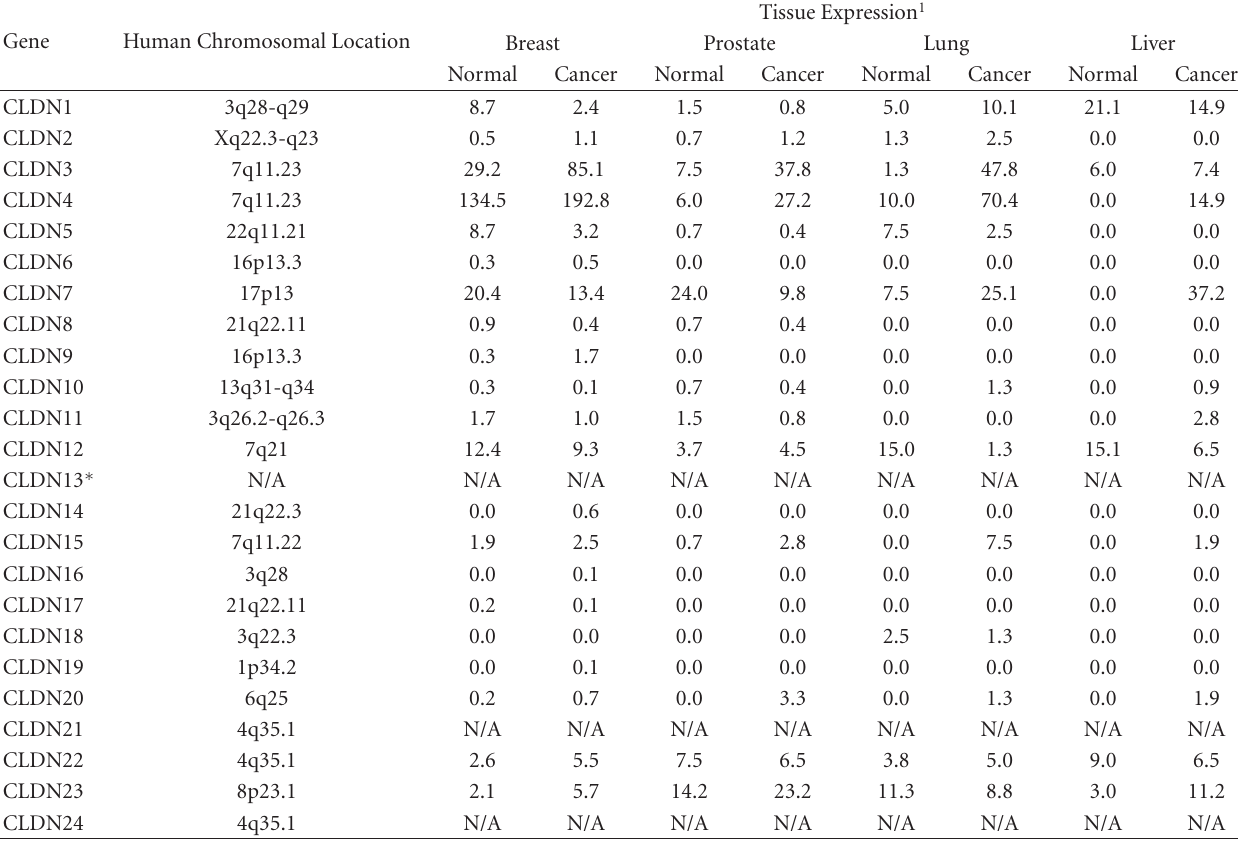
Table 2: Chromosomal locations of the 24 members of the claudin gene family and examples of their tissue-specific gene expression in normal and neoplastic tissues. Homologues for all members of this family (except CLDN21) are also found in chimpanzee, mouse, dog, rat, chicken, and